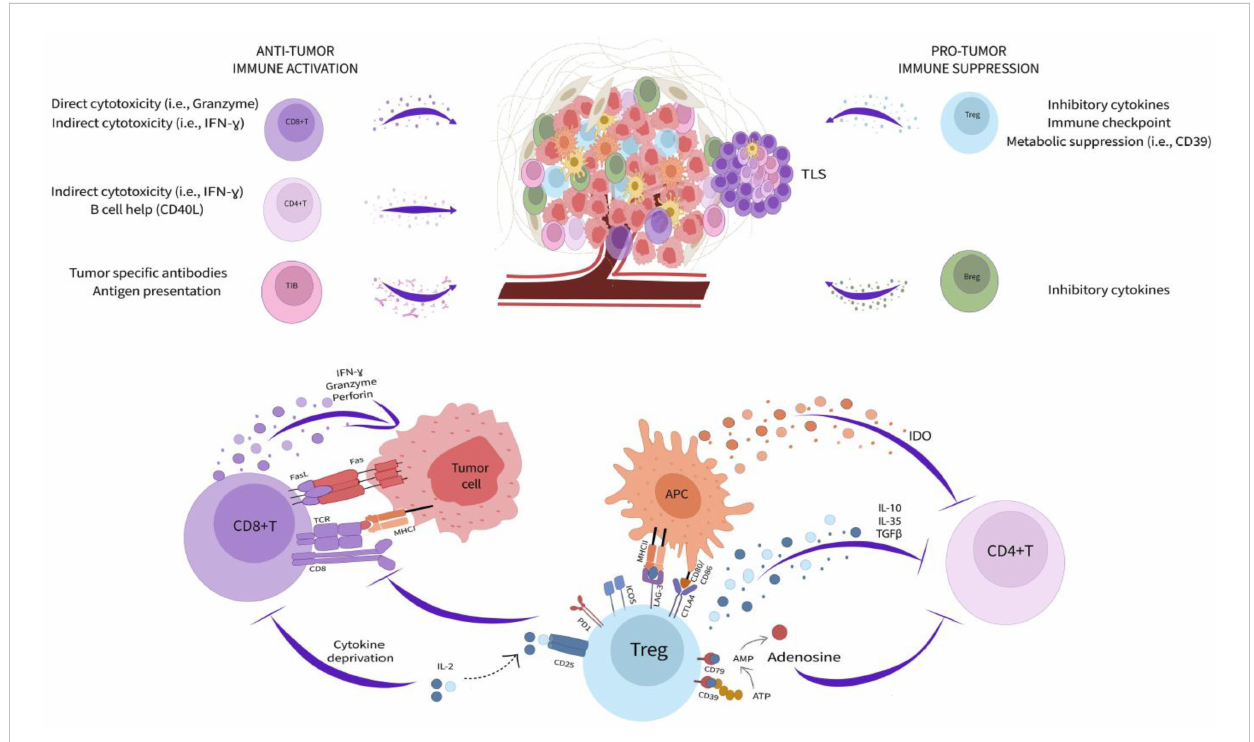
FIGURE 1 Adaptive immunity in the tumor microenvironment. Subsets of adaptive immune cells accumulating within the TME kill cancer cells through a variety of cytotoxicity mechanisms (left side) while other populations (right side) impair immune function and suppress cytotoxic activity contributing to continued tumor expansion. Tregs mediate immunosuppression within the TME through multiple pathways